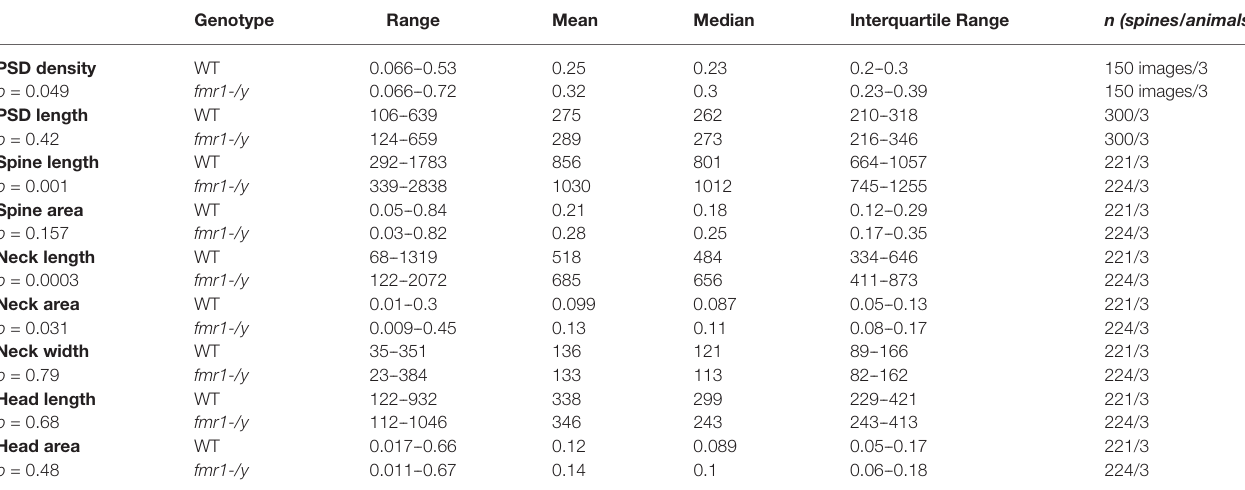
TABLE 1 | Spine analysis parameters and results